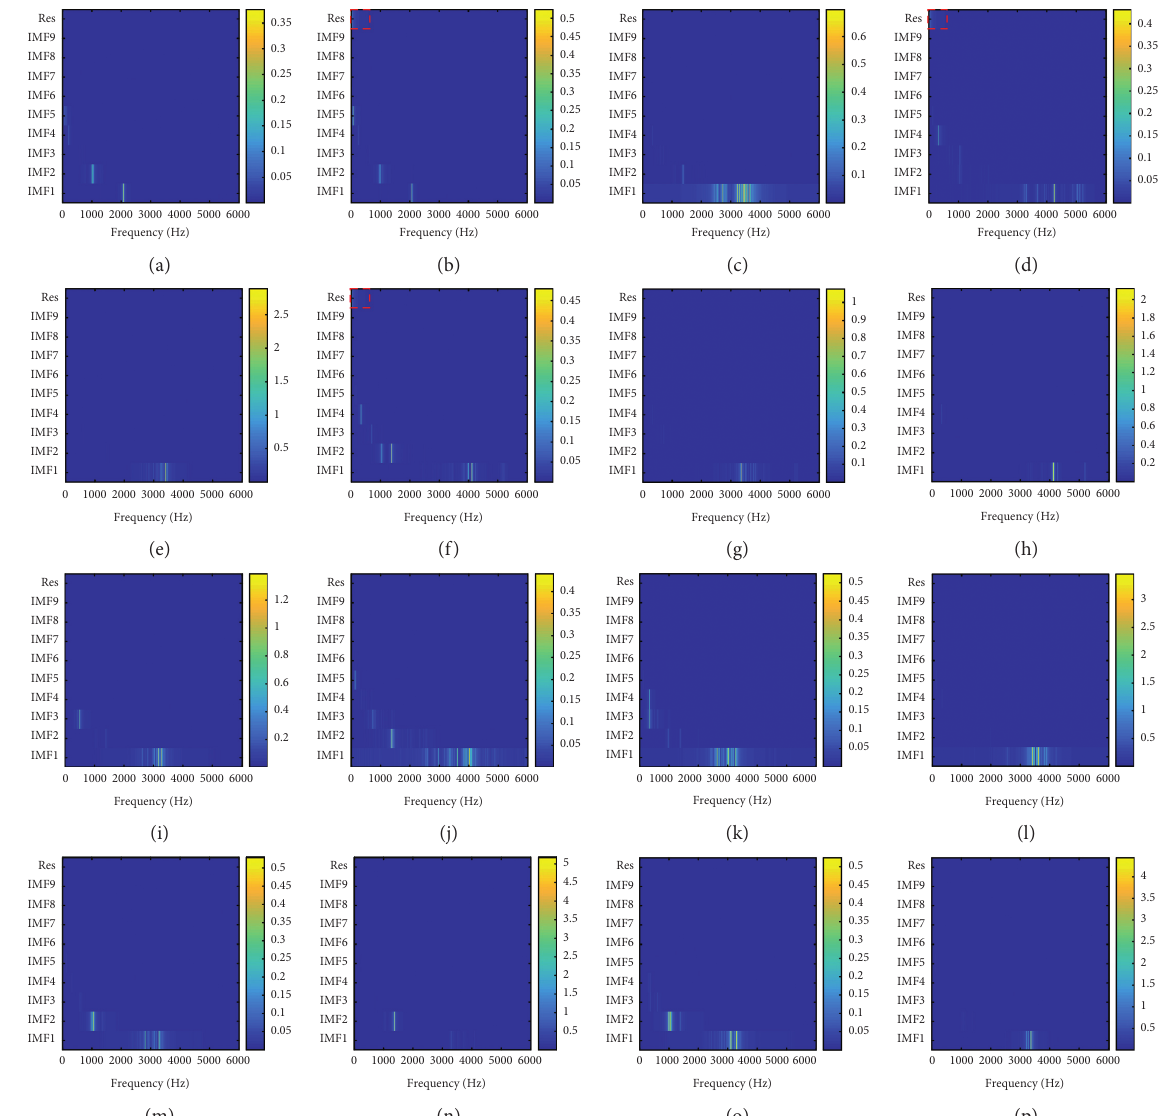
Figure 5: Frequency distribution of each IMFs after autocorrelation denoise. (a) N (drive end). (b) N (fan end). (c) I-D (drive end). (d) B-F (fan end). (e) B-D (drive end). (f) B-D (fan end). (g) O6-D (drive end). (h) O6-D (fan end). (i) I-F (drive end). (j) I-F (fan end). (k) B-F (drive end). (l) B-F (fan end). (m) O3-F (drive end). (n) O3-F (fan end). (o) O12-F (drive end). (p) O12-F (fan end). Res means residual